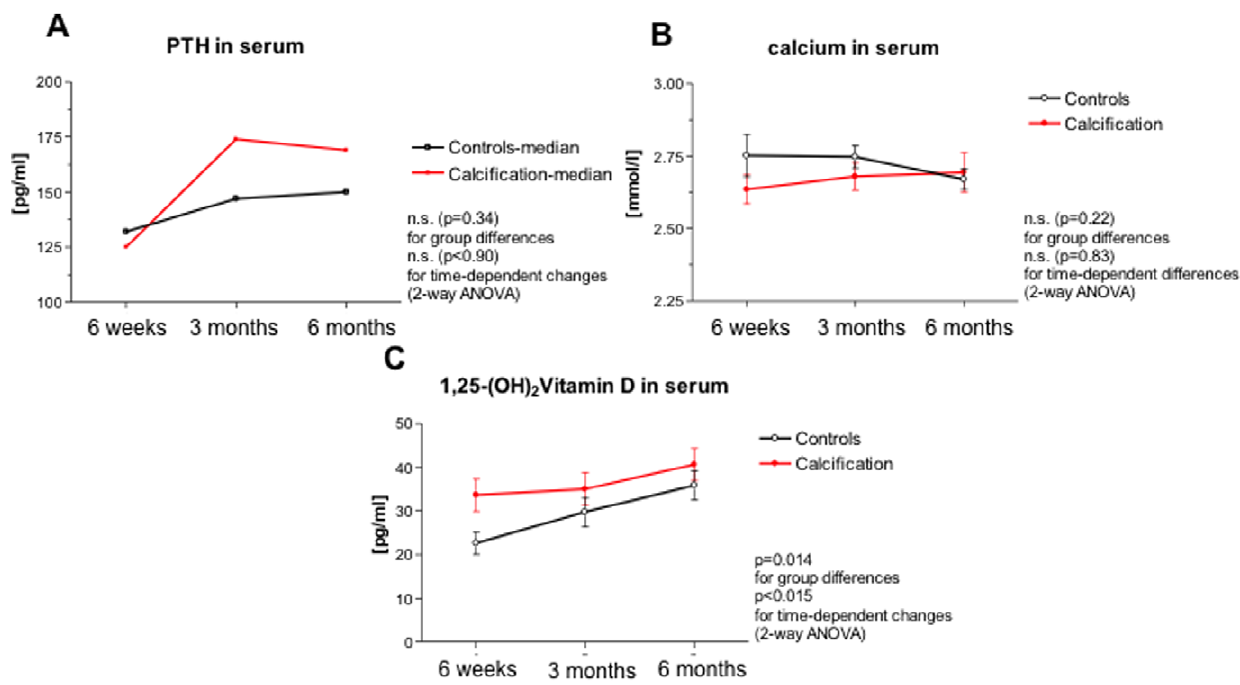
Figure 1. Levels of parathyroid hormone (A), serum calcium (B) and vitamin D (C) are shown in NC patients and controls at the indicated time points. Patients with calcification are depicted in red. Data are shown as mean 6 standard error of the mean (SEM). patient groups did not differ concerning Vitamin D supplemen- tation or phosphate supplementation. A few patients received cinacalcet at 6 weeks and 3 months after transplantation (NC: